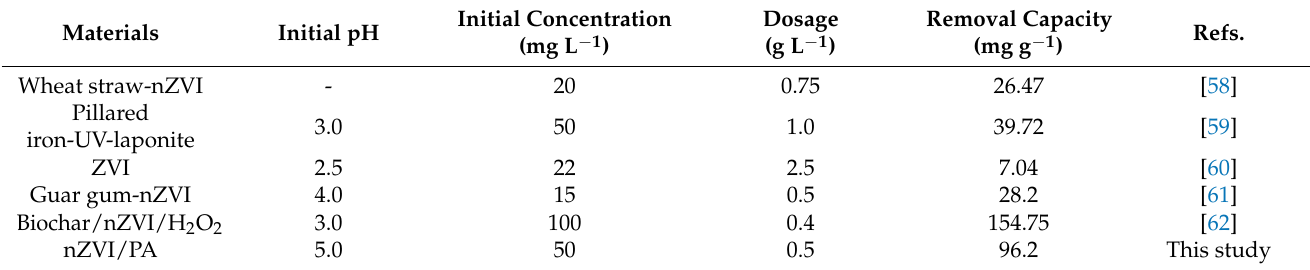
Table 1. Comparison of CIP removal by nZVI/PA and other